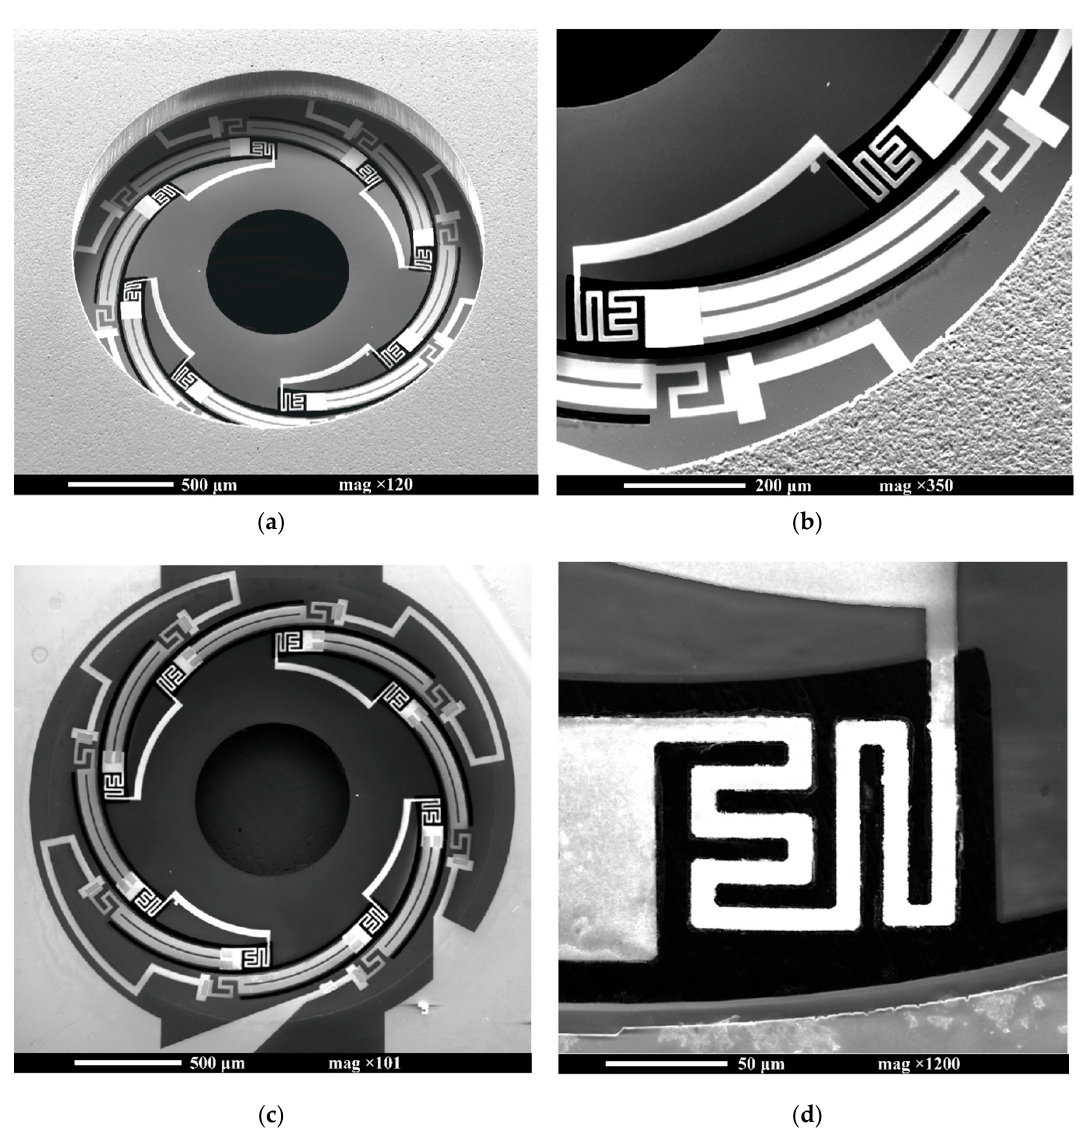
Figure 7. SEM images of the fabricated electrothermal kirigami scanner: ( a ) frontside perspective view of freestanding SiN film (2 mm in diameter) on which the spiral-curved cuttings were strategically placed; ( b ) detailed view of thermal bimorph area, including the serpentine spring and guard heater; ( c ) backside view of the SiN film where NiCr patterns and W patterns were deposited; ( d ) detailed view of the serpentine mechanical spring.